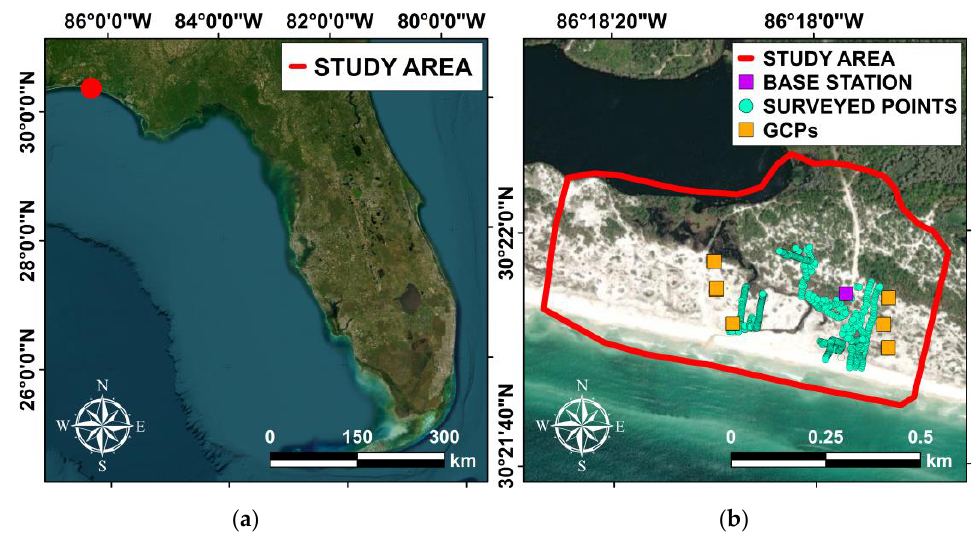
Figure 2. The location of our study area, Topsail Hill Preserve State Park, on the Gulf coast ( a ), and in Santa Rosa Beach, FL, USA ( b ). The light blue dots indicate the points surveyed in the study area by using a RTK – GPS rover. The orange squares indicate the location of the ground control points. The violet square indicates the location of the base station.